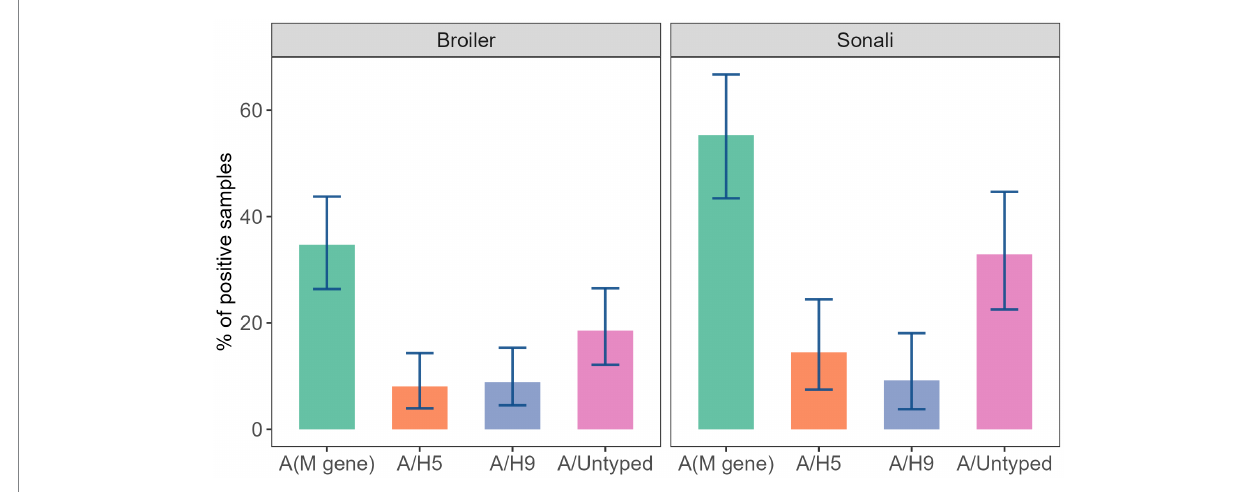
FIGURE 4 Diversity and prevalence of AIV subtypes in Sonali and Broiler in studied LBMs.